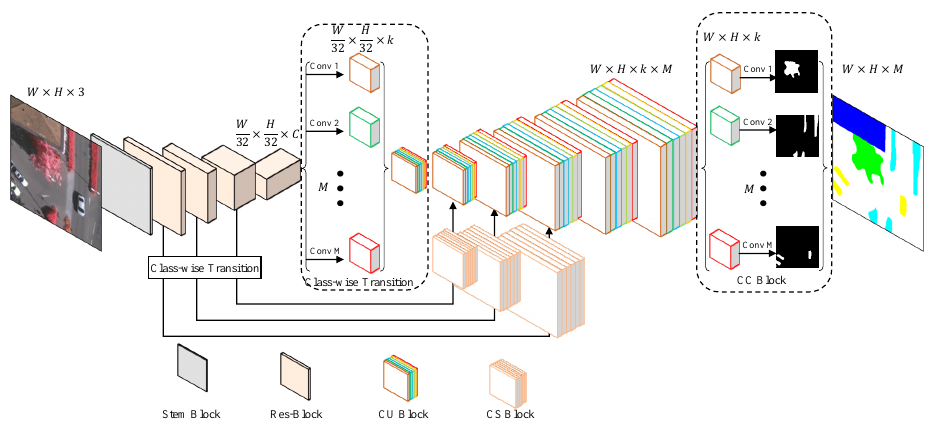
Figure 4. Overview of the proposed model C-FCN. The encoder part is constructed with ResNet-50 and the decoder is implemented by the class-wise up-sampling (CU) block. A class-wise transition (CT) block is designed to communicate the shared encoder structure with the class-wise decoder part. The class-wise supervision (CS) block improves skip-connections to deal with the fusion of general features and specific features. And the class-wise classification (CC) module produces segmentation results by making predictions on class-wise features with the group